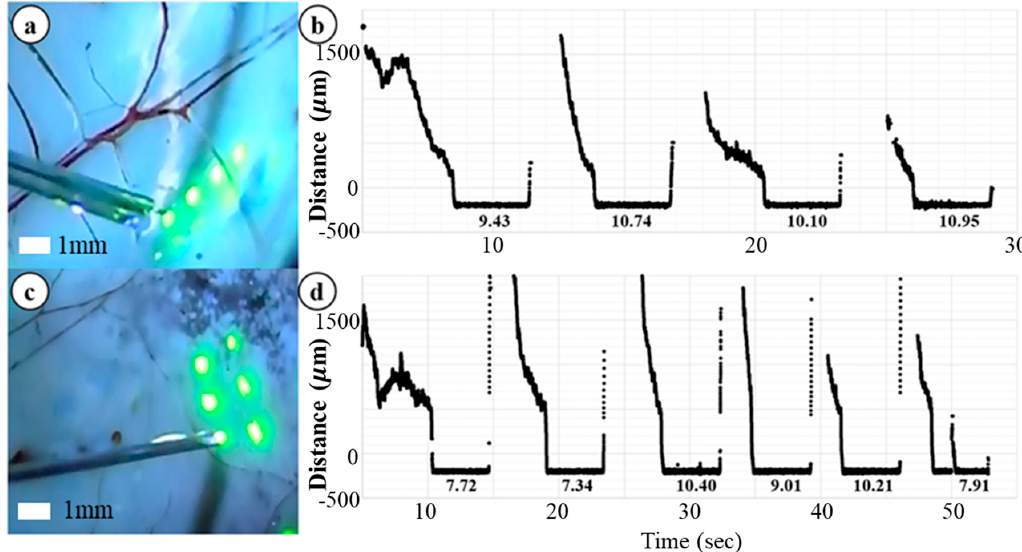
Figure 7. The ex-vivo bovine eye injection experiment: ( a , c ) are snap shots displaying the multiple fluorescein injections. Fluorescein was excited by blue light for fluorescence emission, ( b , d ) are tracking data of the needle-tip. Each graph has root mean square error (RMSE) below it during depth locking.